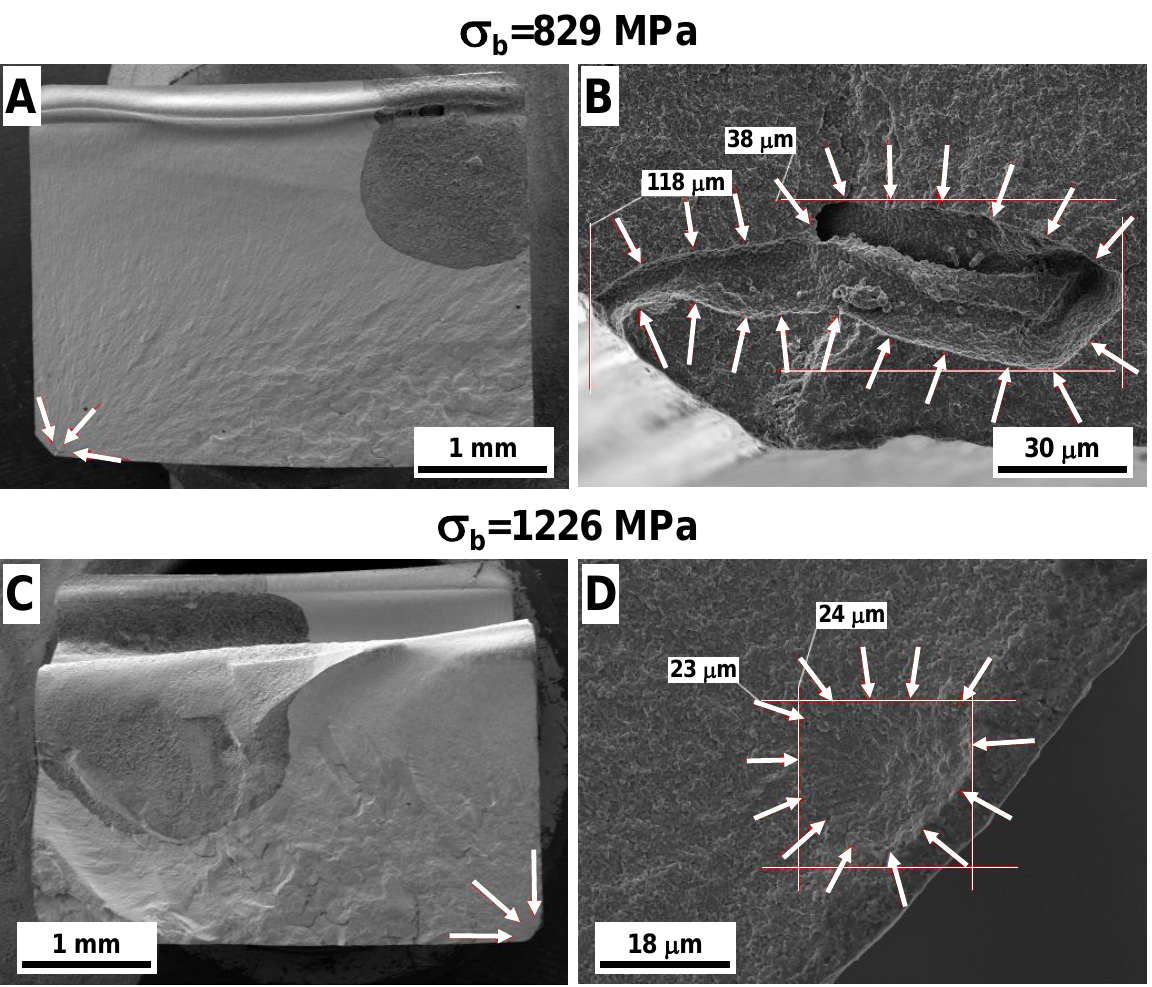
Figure 4. SEM micrographs of fracture surfaces of Y-TZP ceramics. The overall fracture surfaces of Y-TZP samples failed at 829 MPa ( A ) and 1226 MPa ( C ), where locations of fracture origins are marked with arrows. The fracture origins of Y-TZP samples failed at 829 MPa ( B ) and 1226 MPa ( D ). The dimensions of fracture origins in both cases are also shown.